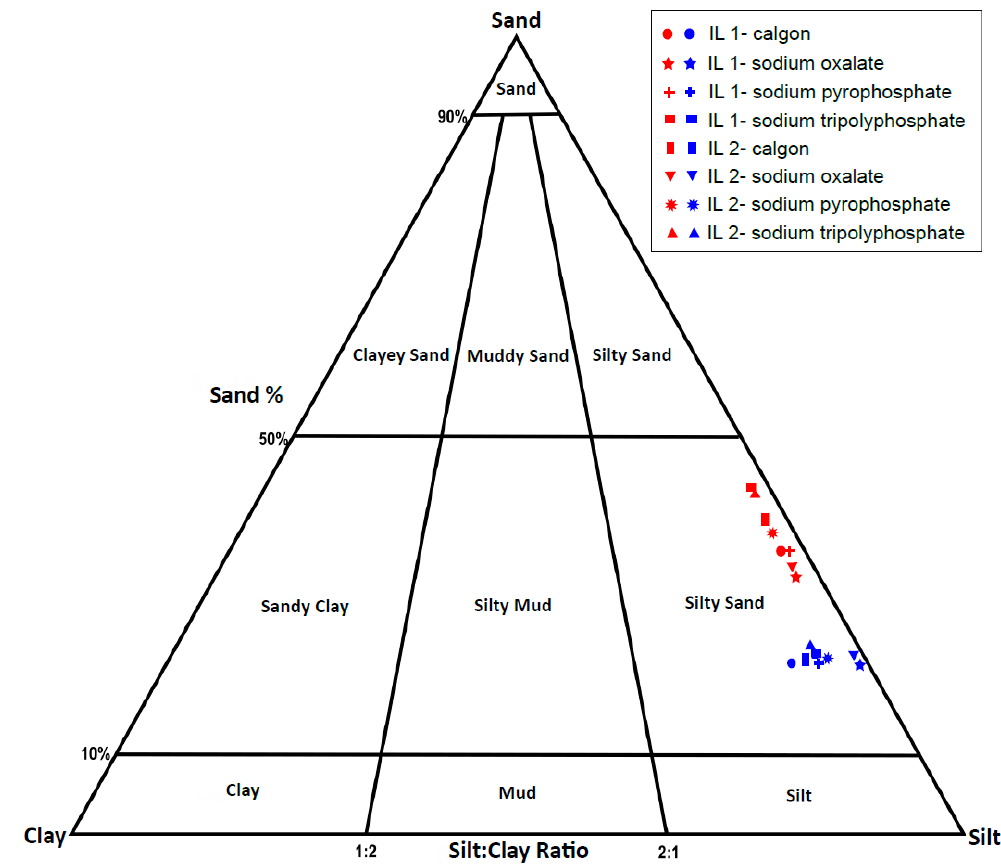
Figure 4. Ternary diagram illustrating the proportions of sand, silt, and clay in IL 1 and IL 2 sediment samples. The samples treated with H 2 O 2 (Group A) are represented with blue while red represent samples treated by thermal combustion (Group B). Table 4. Summary of statistical grain size parameters; mean grain size (MGS), and clay content for samples IL1 and IL2, with Group A being treated using hydrogen peroxide and Group B with thermal